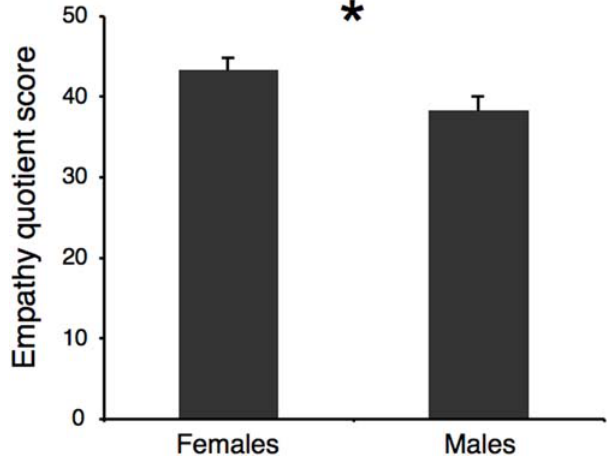
Figure 4. Mean empathy quotient score for male and female participants. *: p ,